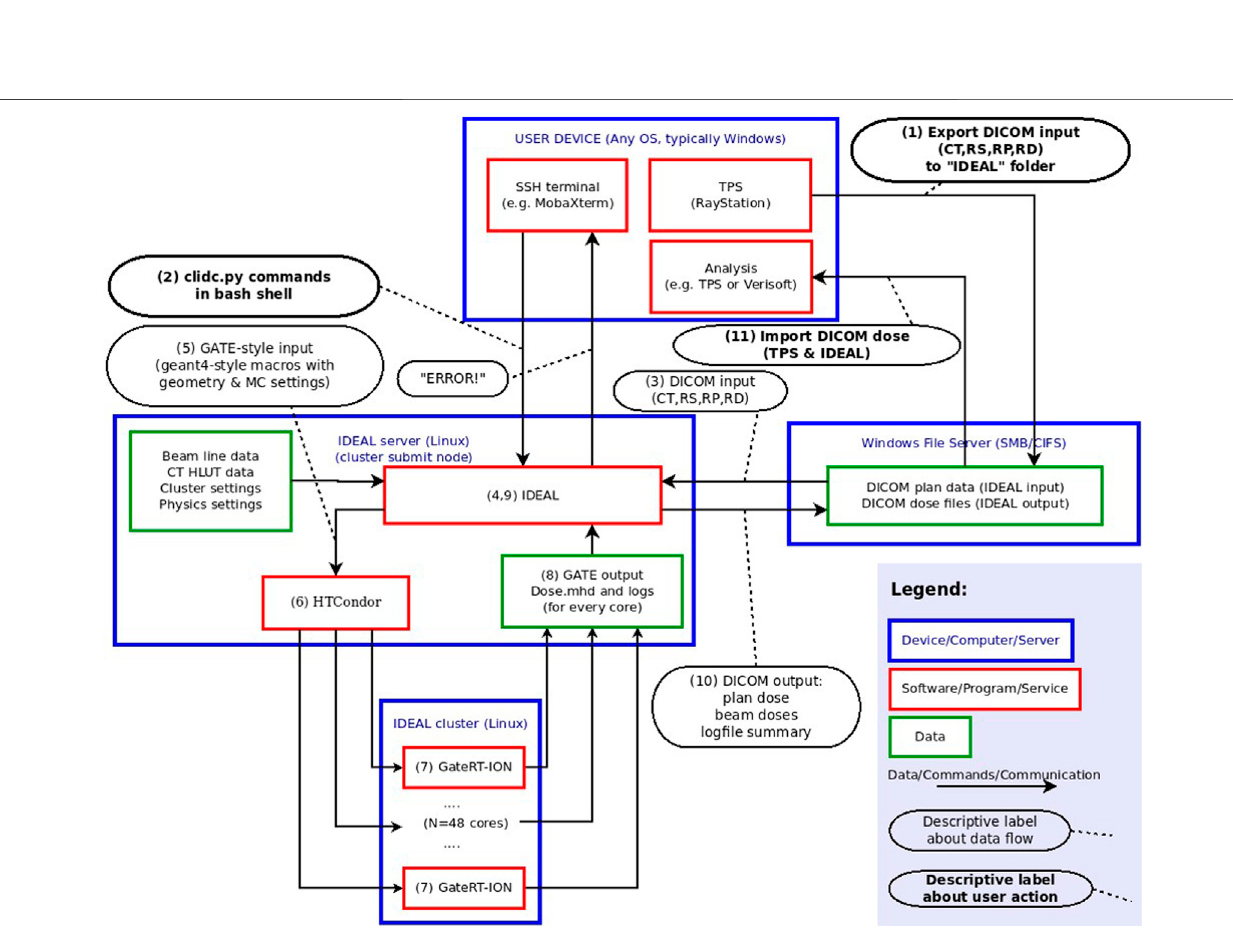
Frontiers in Physics |